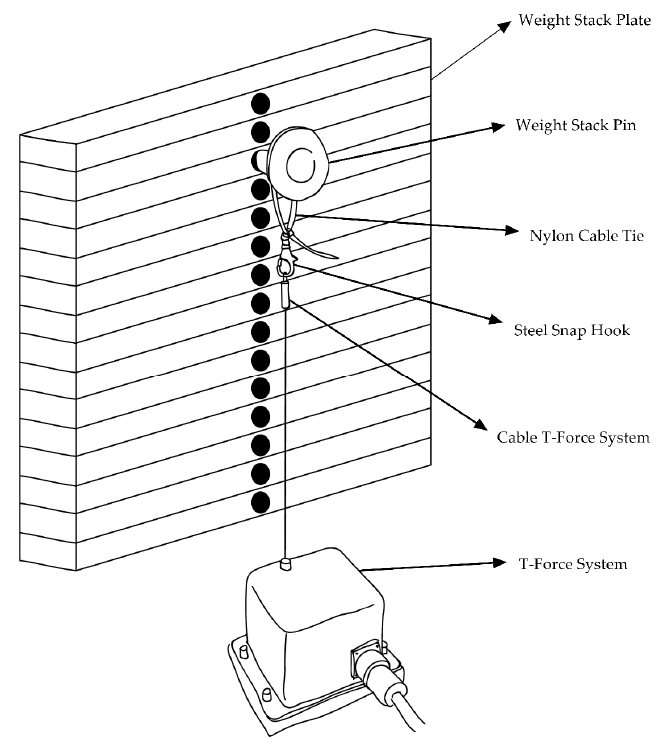
Figure 3. Illustration of the connection between the T-Force System and the resistance